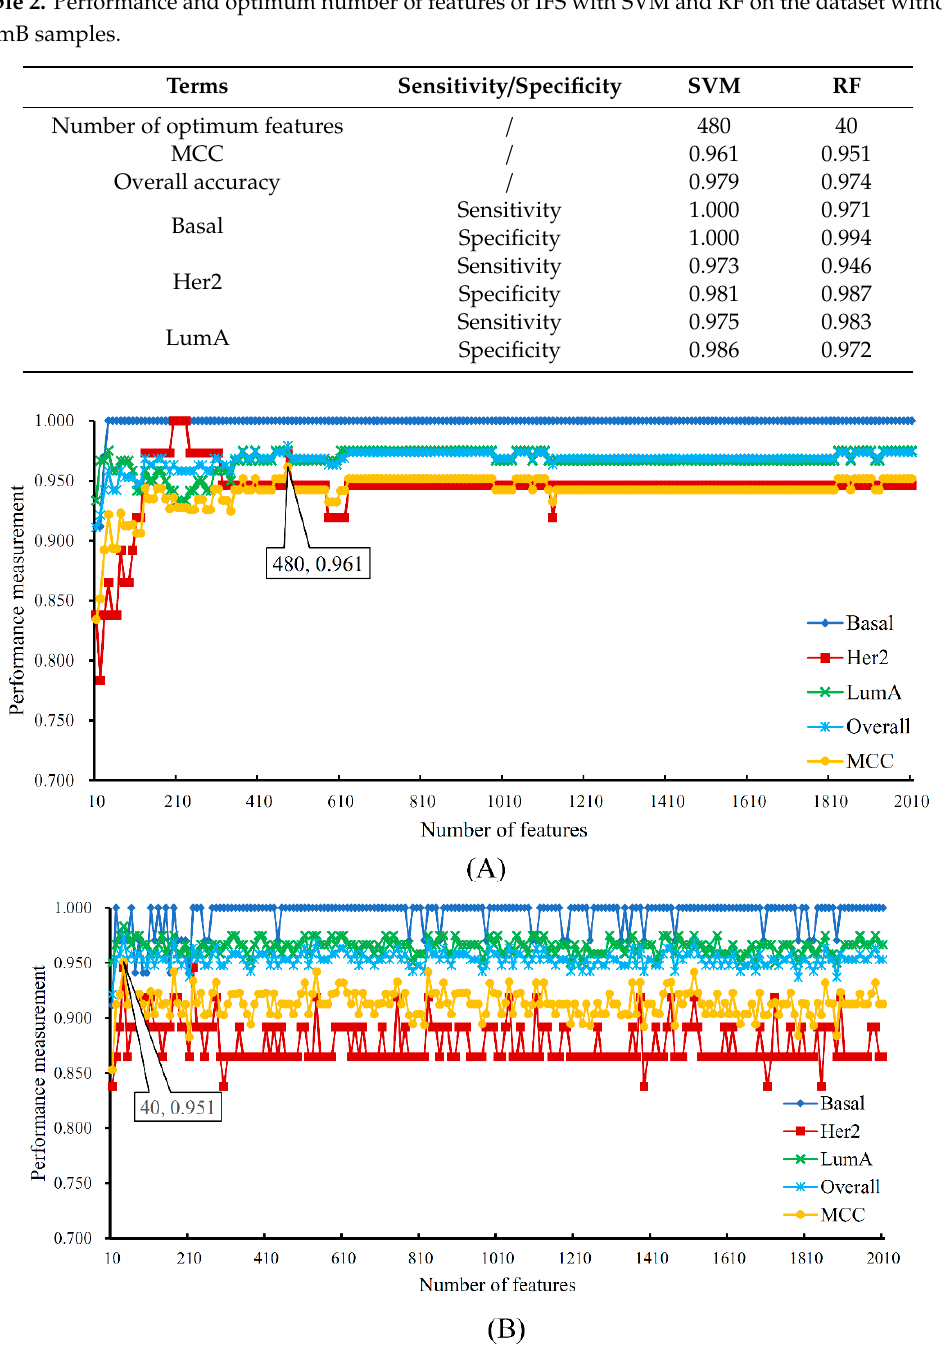
Figure 3. The performance of support vector machine (SVM) and random forest (RF) change with the number of features on the dataset without LumB samples. ( A ) The performance of SVM; ( B ) The performance of RF.